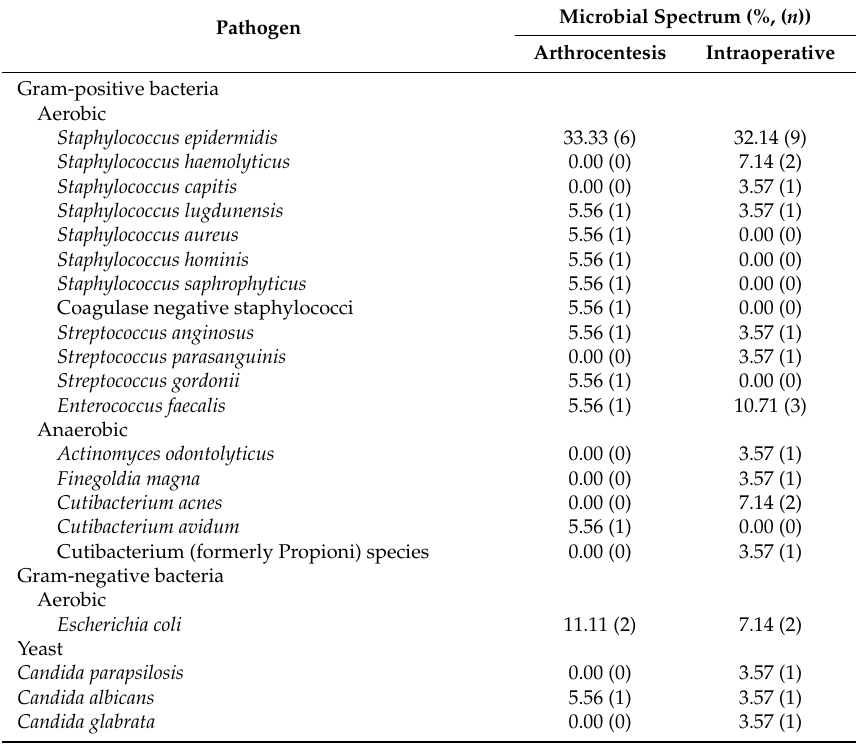
Table 1. Descriptive Overview of Microbial